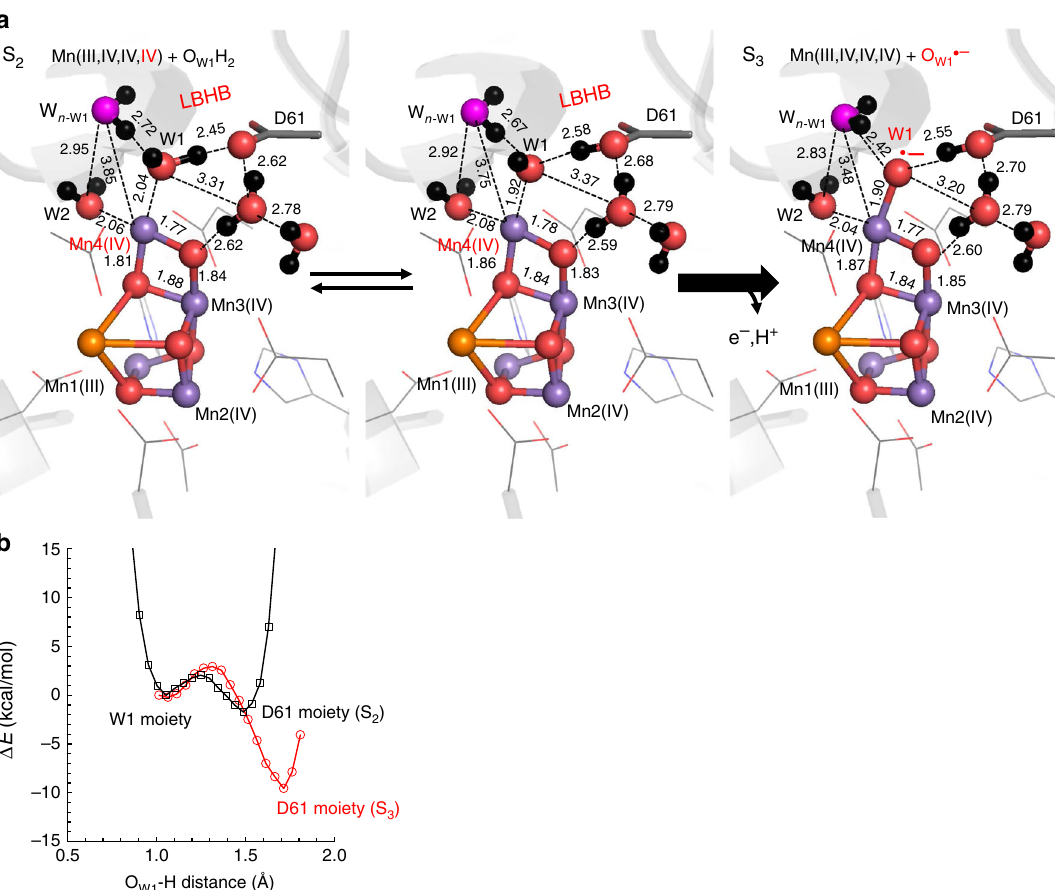
Fig. 2 The open-cubane S 2 -to-S 3 transition. a QM/MM geometries. Mn, Ca, O, and H atoms are represented by purple, orange, red, and black balls, respectively. Dotted lines indicate distances (excluding H atoms). b The energy pro fi les of the H-bonds between W1 (H 2 O/OH – ) and D1-Asp61 in S 2 and W1(OH (cid:129) /O (cid:129)– ) and D1-Asp61 in S 3 . The black curve corresponds to release of the proton from H 2 O at W1 to D1-Asp61 in S 2 , whereas the red curve corresponds to release of the proton from OH (cid:129) at W1 to D1-Asp61 in S 3 . The spin con fi gurations (e.g., high, low, ferromagnetic, and antiferromagnetic) did not essentially affect the resulting optimized Mn 4 CaO 5 geometries and potential-energy pro fi les (Table 1 and Supplementary Figure 1)